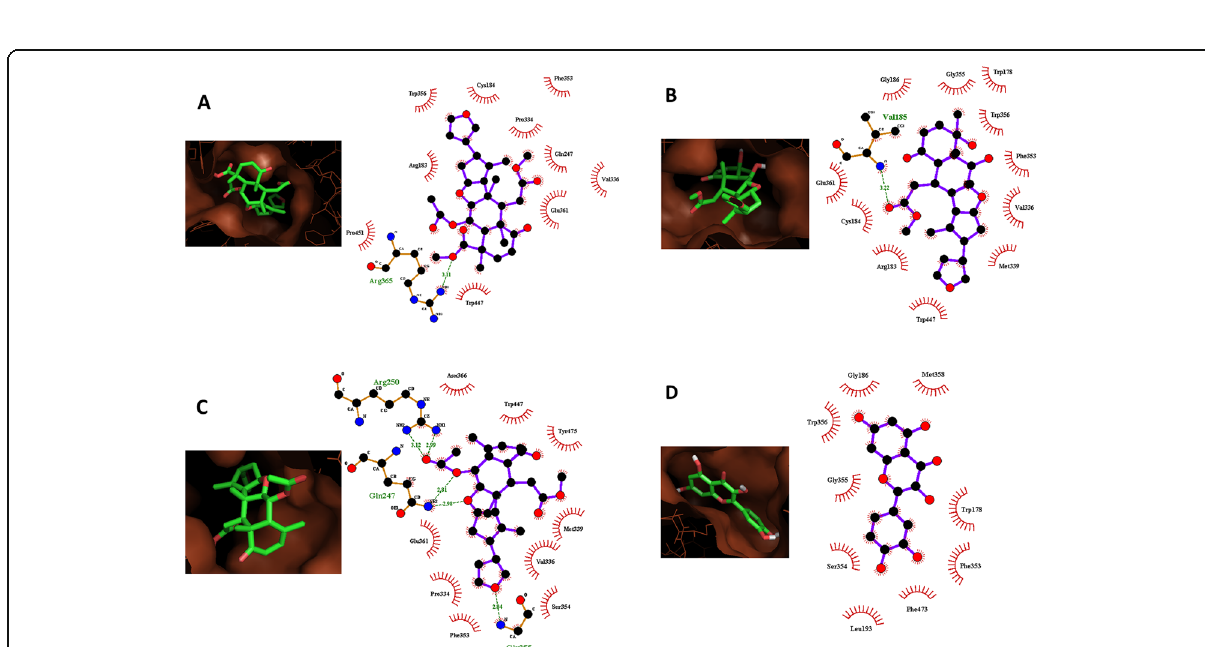
Fig. 3 The binding configuration of A. indica phytoconstituents and interaction analysis. Binding poses of a Nimbin, b Nimbandiol, c Nimbinene, and d Quercetin on NOS active site as obtained from molecular docking using AutoDock Vina. Result of 2D interaction analysis shows hydrogen bond (green dashed lines) and hydrophobic interaction (red curved lines) using